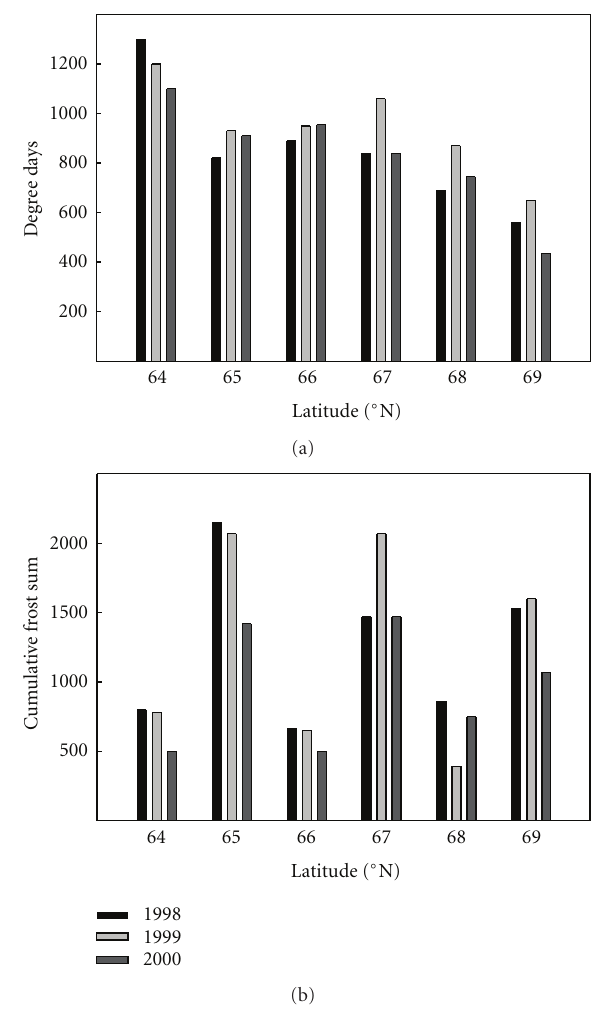
Figure 2: Degree days (a) and cumulative frost sum (b) at the transplantation sites at the seedlings heights during